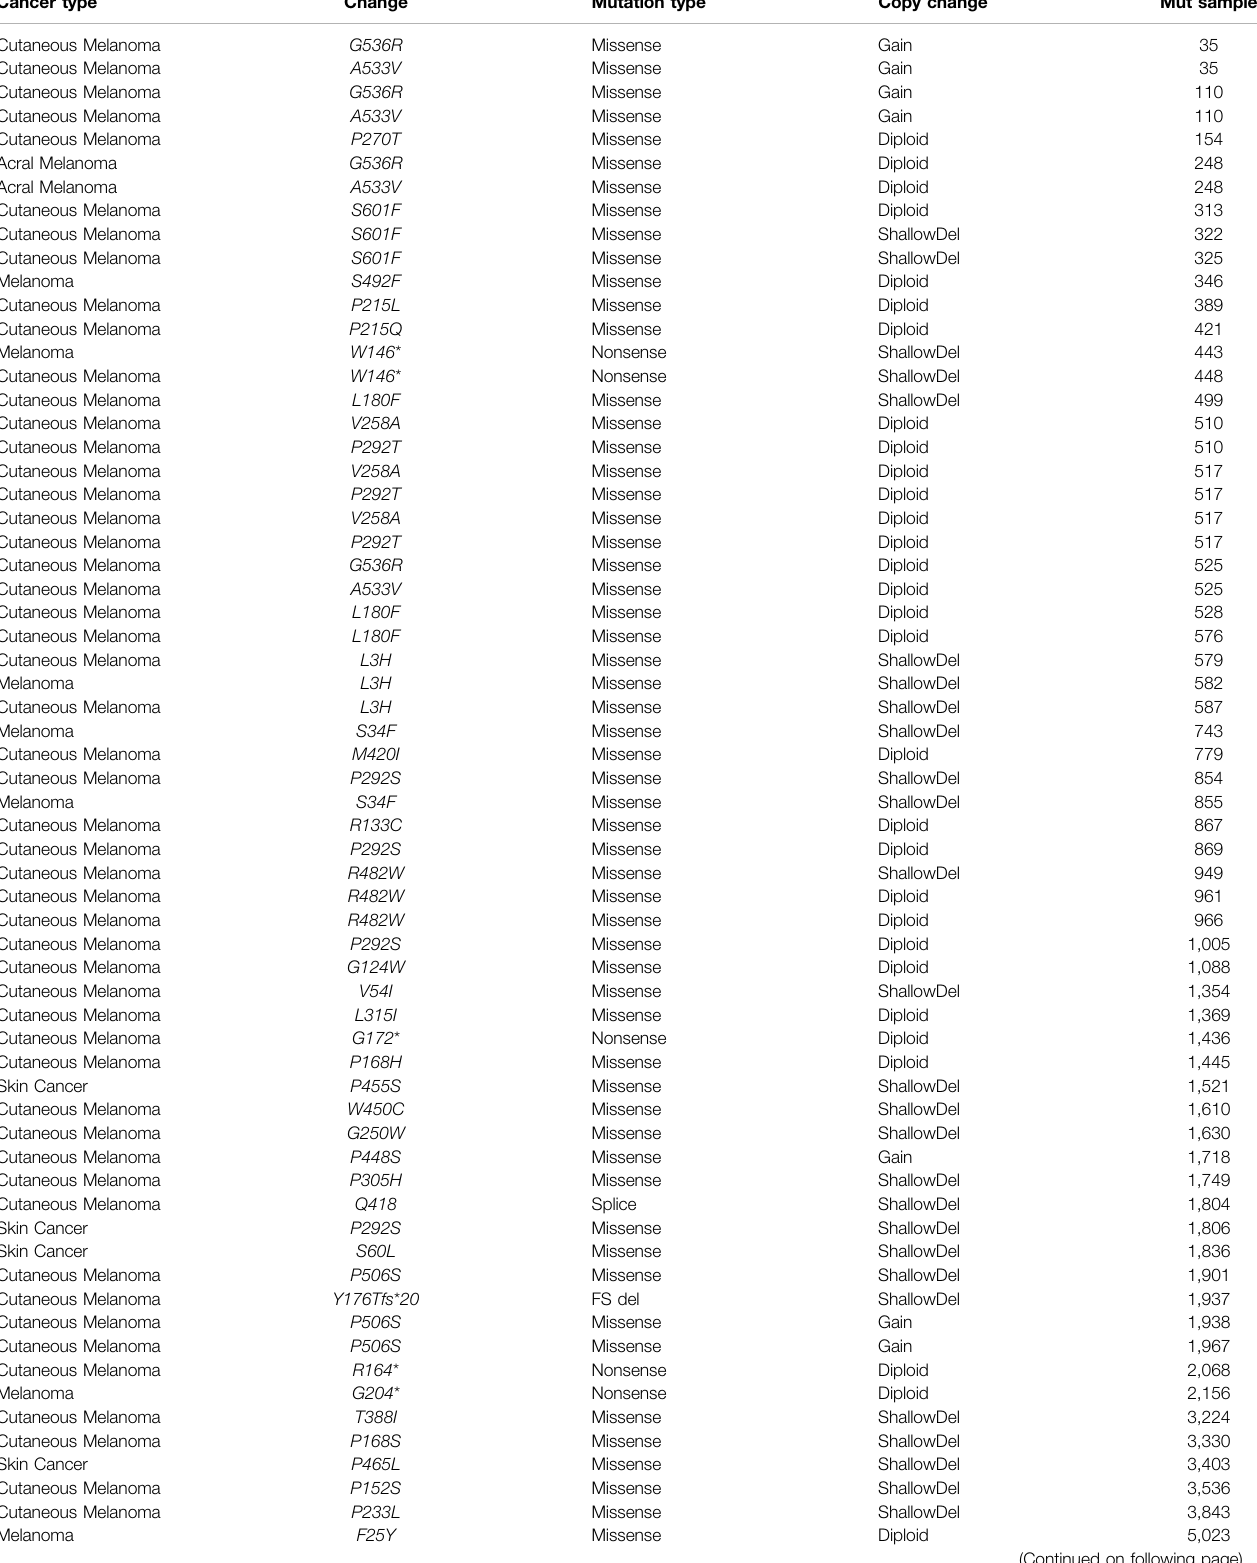
TABLE 1 | RETSAT mutations in SKCM determined by cBioportal